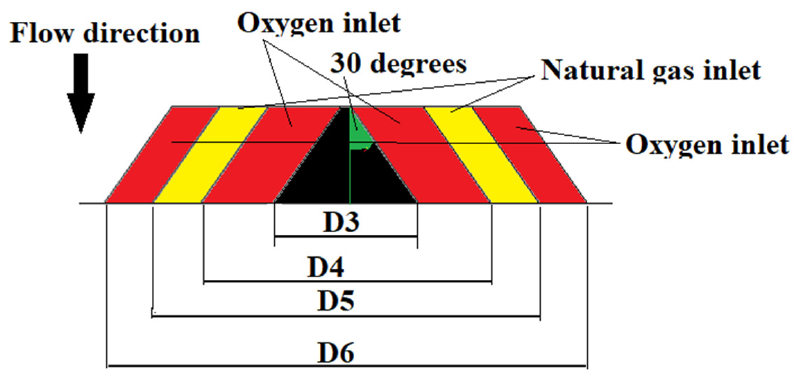
Figure 24. Schematic representation of the burner. Table 10. The dimensions of the industrial